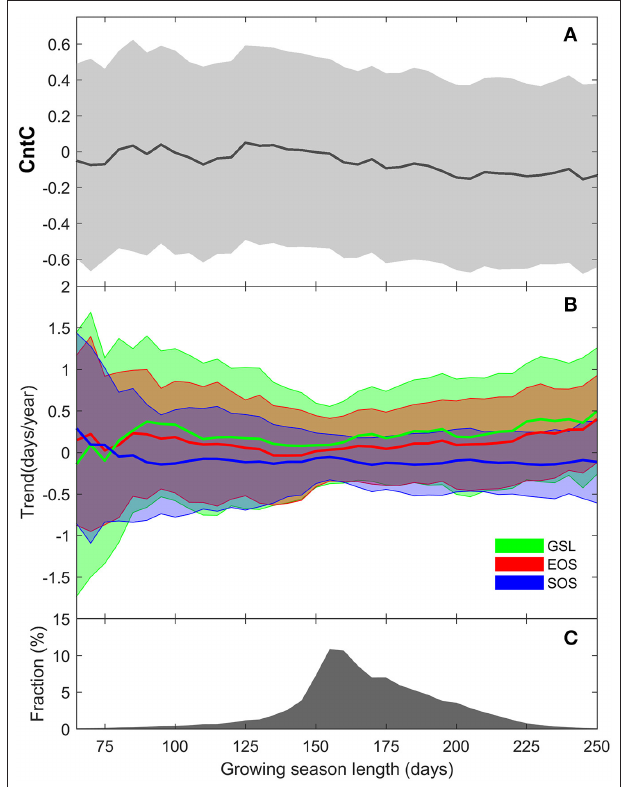
FIGURE 5 | CntC (A) and phenology trends (B) along growing season length (C)